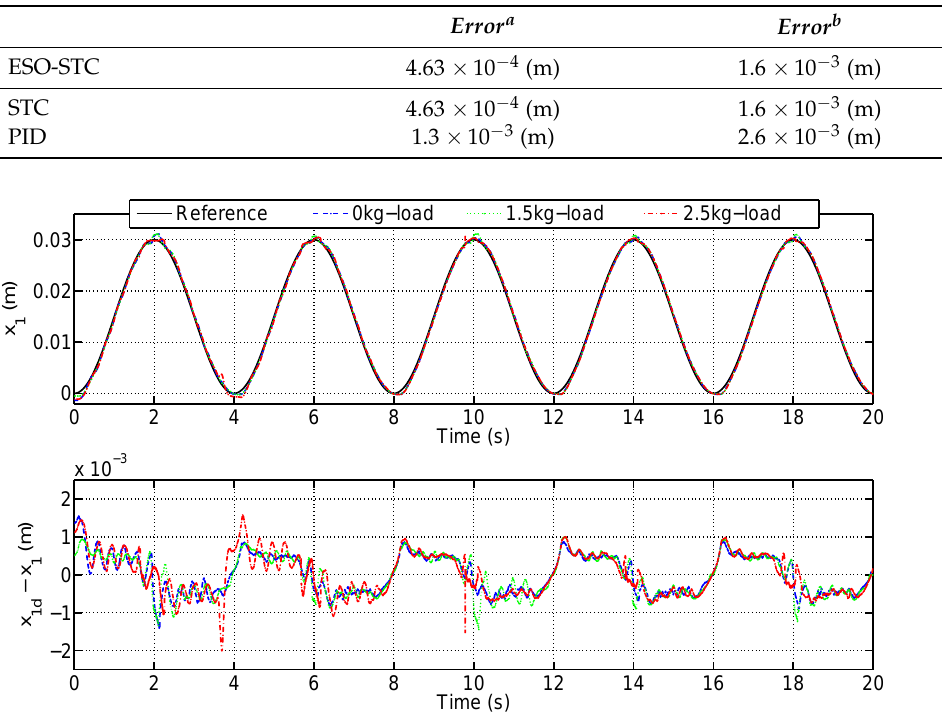
Figure 5. Different loads are suspended to verify the robustness of the